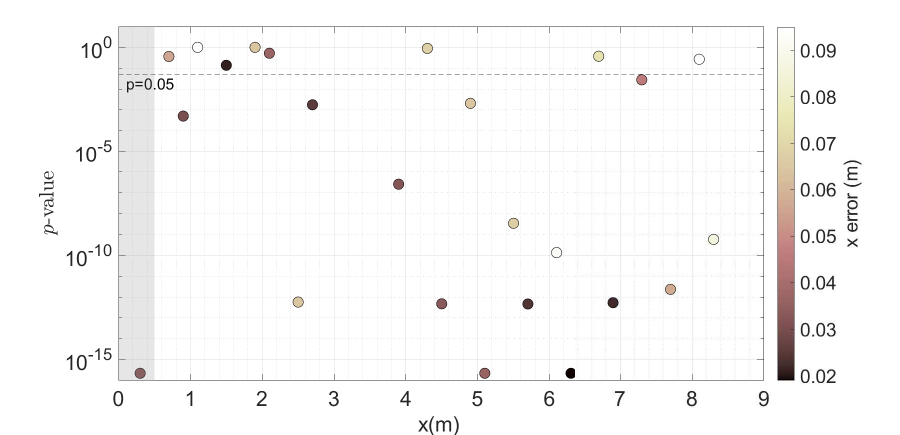
Figure 7. p -values along the profile with regard of the error in location between the centroid of the SB-ADP cell and the ADV point measurementfrom the SuperGen Marine tidal array project